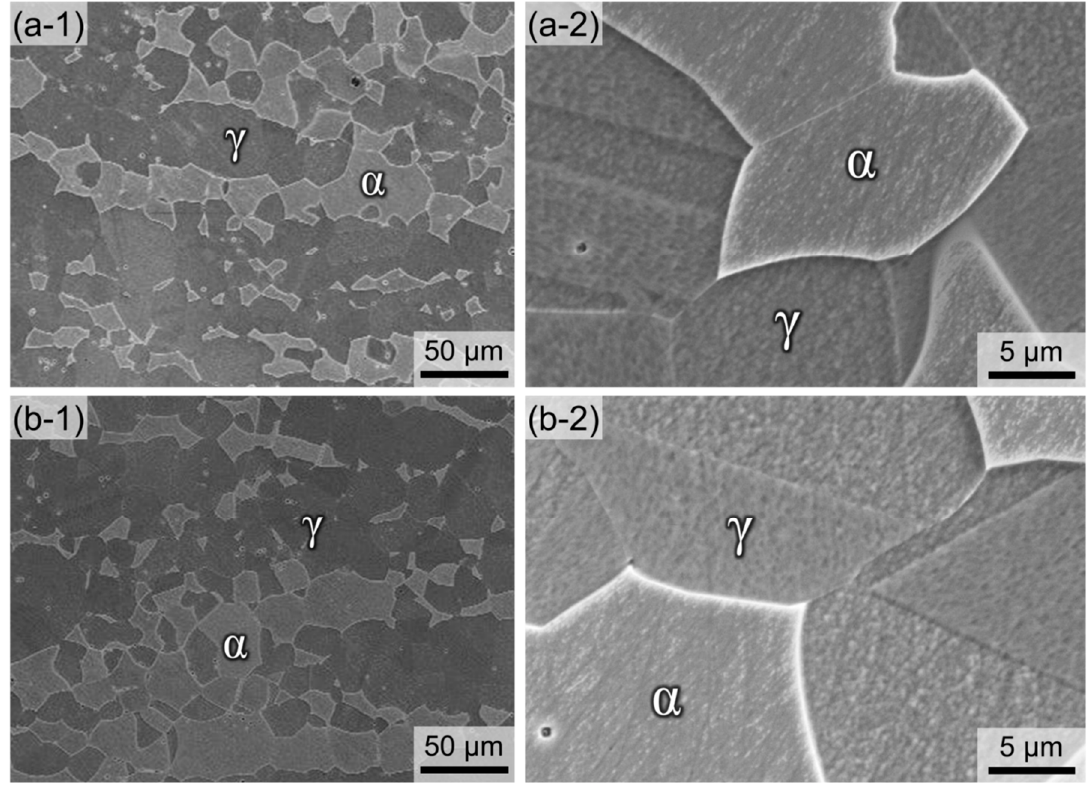
Figure 2. Microstructures of ( a-1 , a-2 ) Ni03 and ( b-1 , b-2 ) Ni57 alloys observed using a SEM taken at ( a-1 , b-1 ) low and ( a-2 , b-2 ) high magnifications.